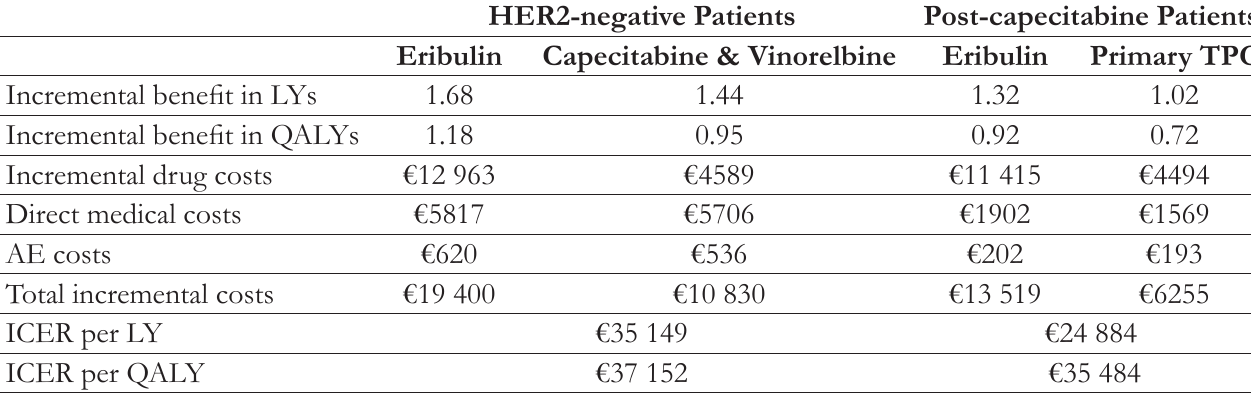
Table 9. Summary of Cost-effectiveness Results